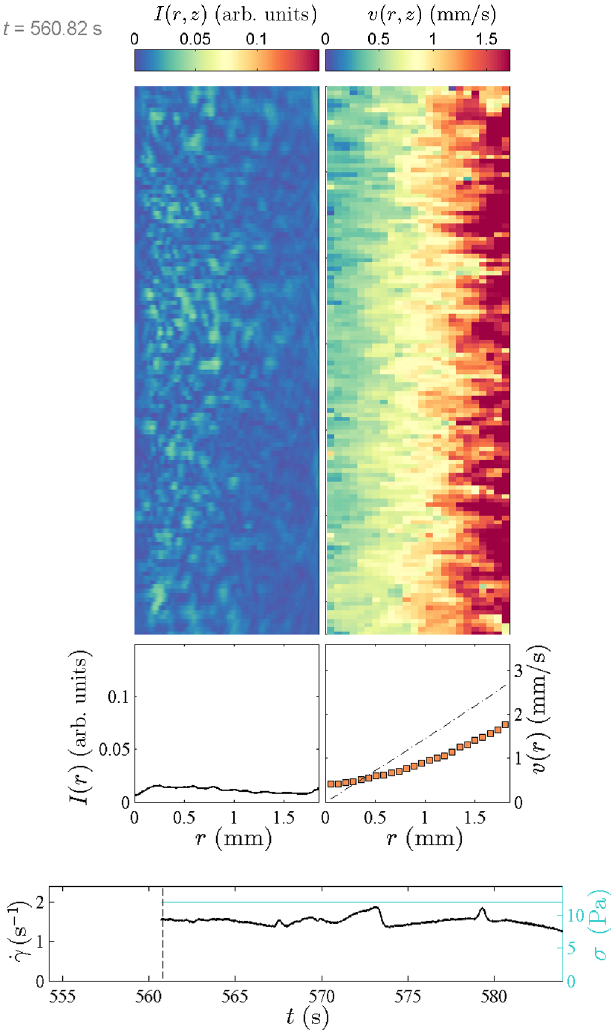
VIDEO 1. Experiment at σ ¼ 12 Pa (regime I). Top panels: Instantaneous maps of the ultrasonic intensity I ð r; z; t Þ (left) and of the tangential velocity v ð r; z; t Þ (right). The vertical z axis covers 32 mm and the horizontal r axis spans the entire gap of 2 mm. The rotor is located at r ¼ 2 mm. Middle panels: Same data averaged over the vertical direction z . Bottom panels: Rheological signals _ γ ð t Þ (black) and σ ð t Þ (blue) recorded by the rheometer simultaneously to the ultrasonic data. The vertical dashed line indicates the current time in the video.